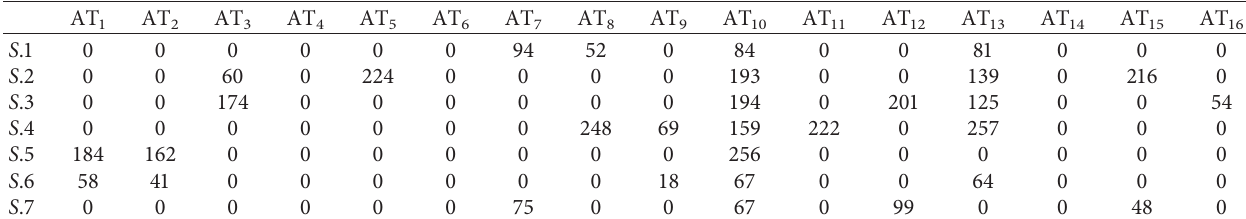
Table 4: The strike time of partial simulation results for 5 random